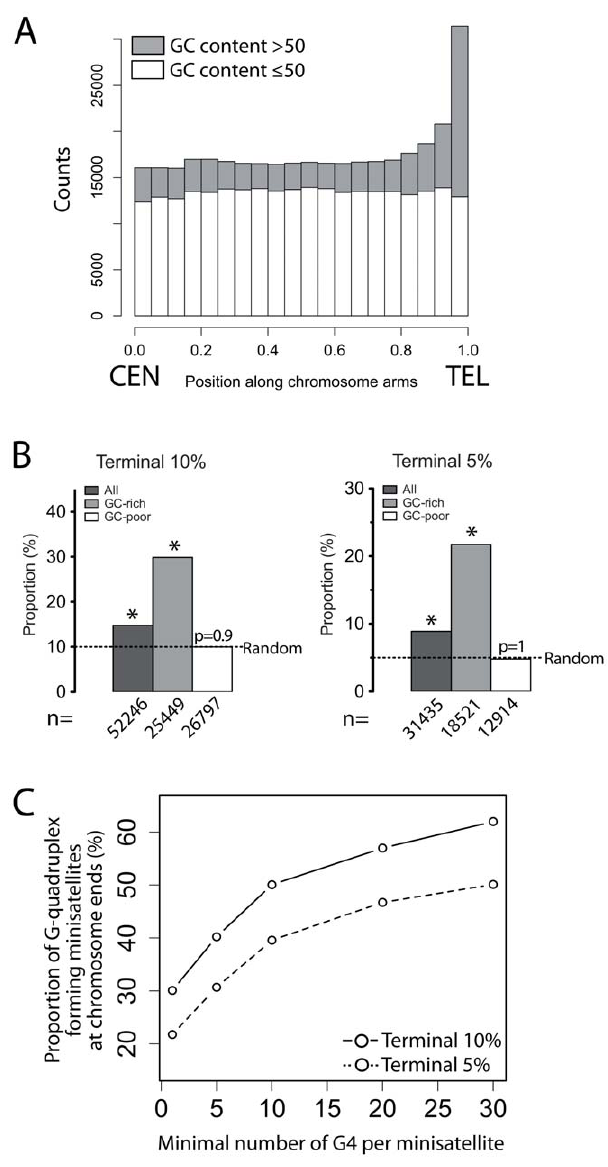
Figure 6. GC–rich and G-quadruplex-forming minisatellites are enriched at chromosome ends in the human genome. (A) Distribution of the human minisatellites along a normalized chromo- some arm in the human genome. The centromere (CEN) is at 0, and the telomere (TEL) at 1. (B) Proportion of the GC-rich (GC content . 50%), GC-poor (GC content # 50%), and all the minisatellites in the terminal 10 and 5% on each chromosome arms. n indicates the number of minisatellites. A star (*) indicates a significant enrichment (all p-values , 2e 2 16 ). No enrichment is observed for GC-poor minisatellites. (C) Proportion of minisatellites in the terminal 10% (continuous line) and 5% (dotted line) of chromosome arms as a function of the number of non-overlapping G-quadruplex-forming sequences per